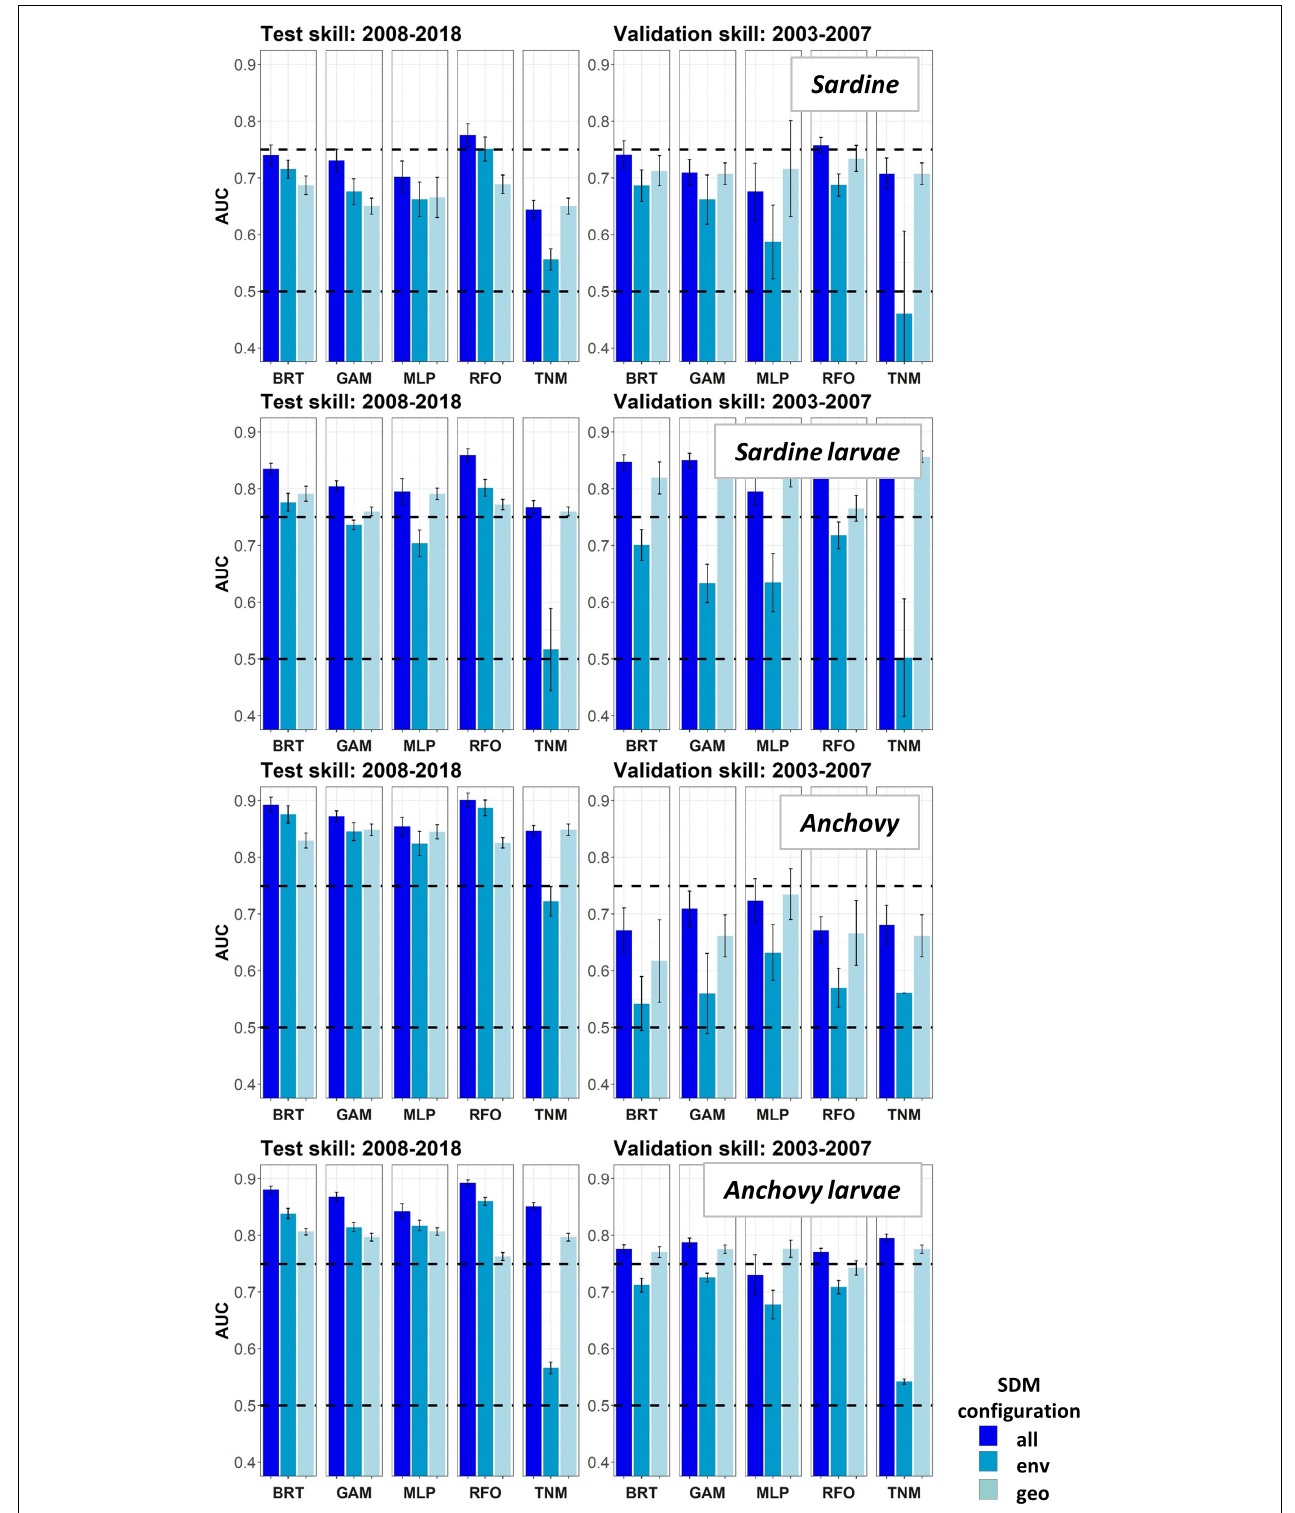
FIGURE 8 | Area Under the Receiver Operating Curve (AUC) skill metrics for Experiment 2 SDMs. Means and standard deviations across all SDM ensembles (see Figure 1 ) are shown for each life stage of each species. Colors of bars denote the SDM configuration (“all,” “env,” or “geo”). The horizontal black dashed lines show AUC values of 0.5 (no better than a random model), and 0.75 (a rough approximation of a “useful” model), for reference.